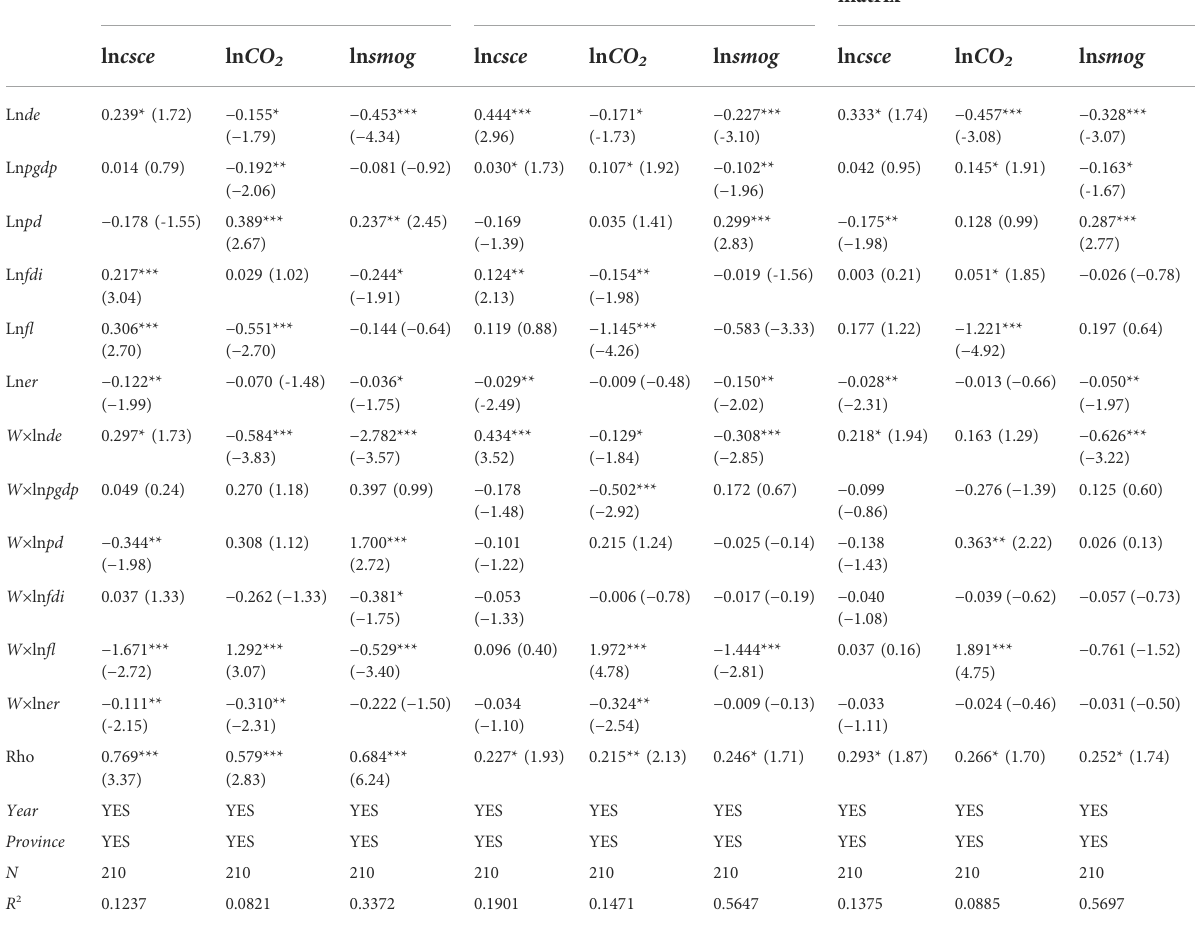
TABLE 4 Spatial regression coef fi cients of the digital economy on the synergistic management of carbon and haze Geographical distance matrix